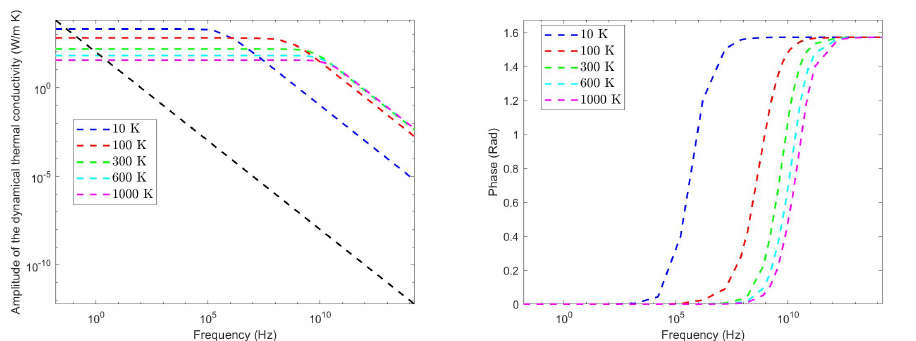
Figure 5. Amplitude ( left ) and phase ( right ) of the Si dynamical thermal conductivity vs. temperature. The black line behaves like 1/ f .